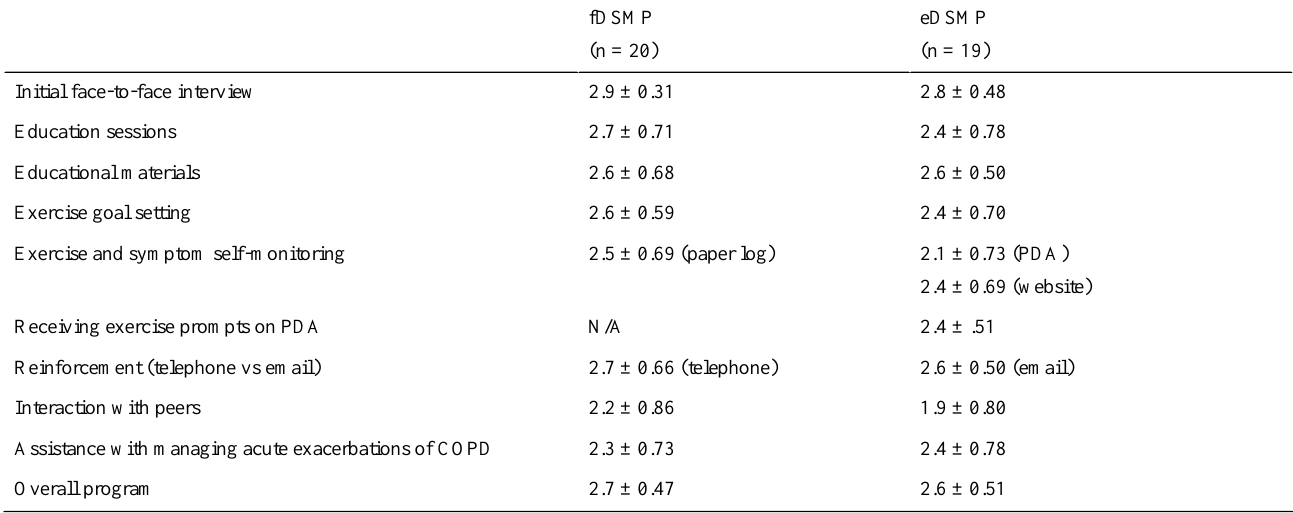
Table 6. Satisfaction with the dyspnea self-management program*